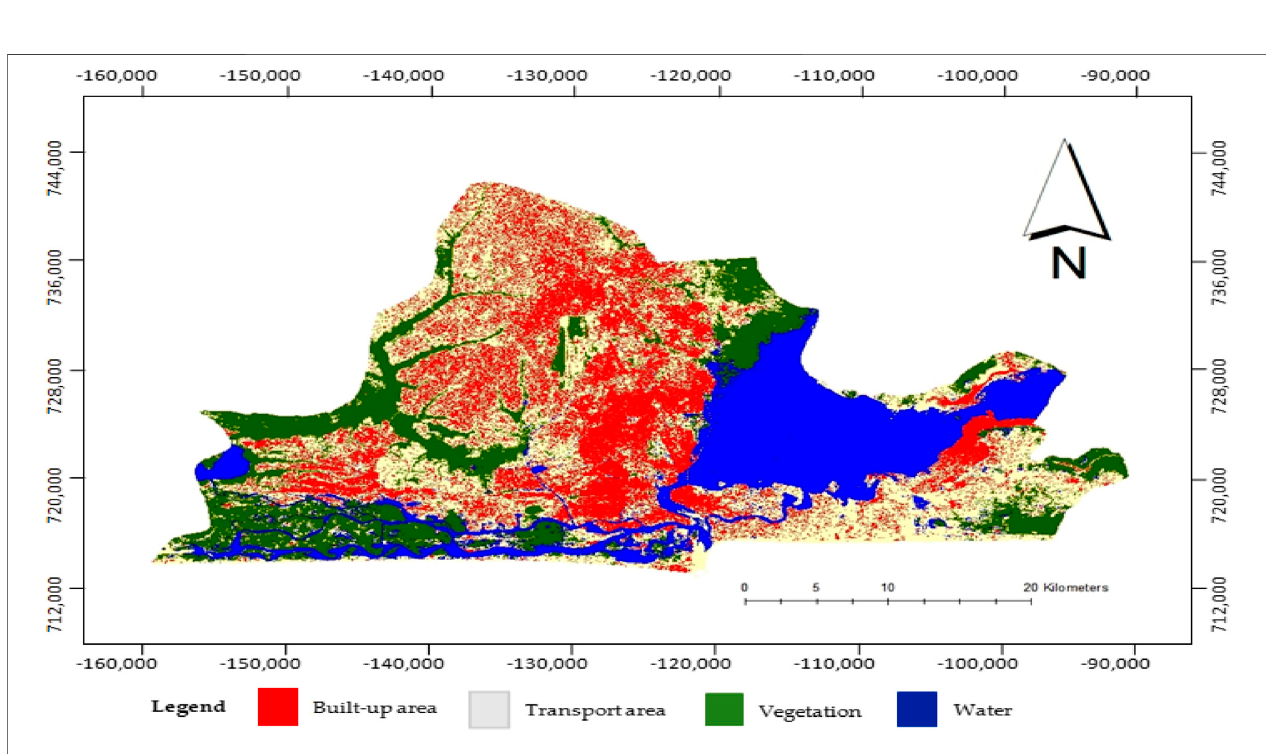
FIGURE 6 | Classi fi ed LULC map of Lagos Metropolis in 2013.